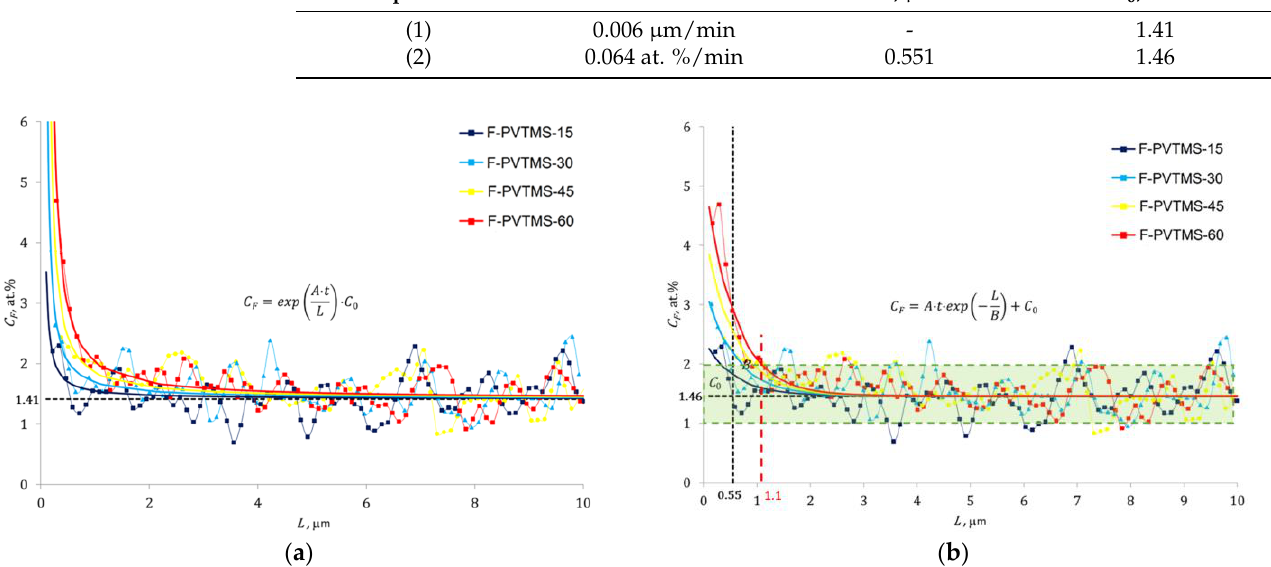
Figure 10. Approximation of the fluorine distribution over the film thickness for different fluorination durations: ( a )—approximation by expression (1); ( b )—approximation by expression (2).